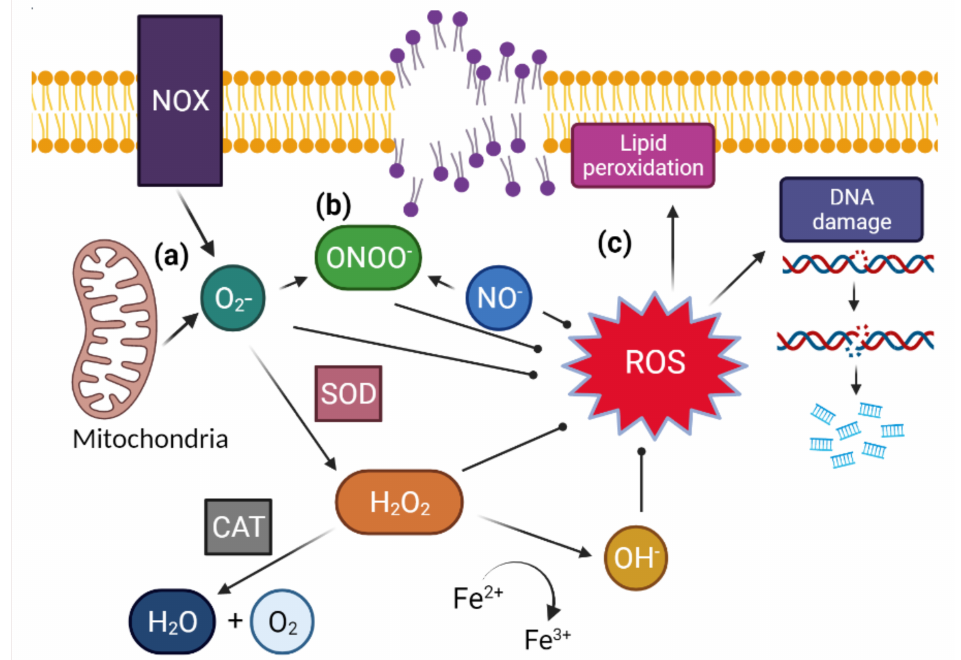
Figure 2. ( a ) ROS formed within the cell starts as superoxide (O 2 − ) created from ATP generation in mitochondria and from NADPH oxidase (NOX), and superoxide dismutates, facilitated by the protein superoxide dismutase (SOD) into hydrogen peroxide (H 2 O 2 ). Hydrogen peroxide can then be neutralized by catalase (CAT) to create water (H 2 O) and singlet oxygen (O 2 ). However, in the presence of ferrous iron it will react, creating hydroxyl radical (OH − ). ( b ) If there is nitric oxide (NO − ) present, then it will react to create peroxynitrite (ONOO − ), a potent but unstable oxidant. ( c ) These ROS contribute to sperm damage through oxidation of the guanine base in DNA, creating single strand breaks, double strand breaks and DNA fragmentation, or through its oxidation of polyunsaturated fatty acids, creating lipid radicals that self-propagate, resulting lipid